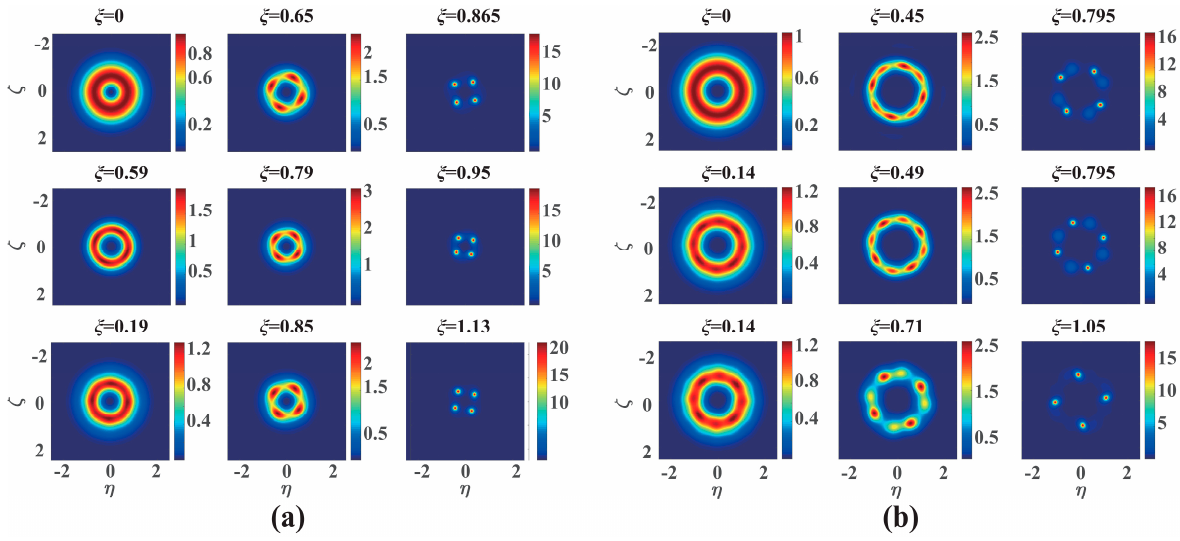
Figure 2. The evolution of vortex beams in a Kerr-ROLP medium for different modulation depths and modulation factors. ( a ) n = 1, P in = 1.7 P cr , the first to the third rows are, respectively, with V 0 = 0.2, d = 0.31; V 0 = 0.2, d = 0.23; V 0 = 0.7, d = 0.23. ( b ) n = 2, P in = 1.4 P cr , the first to the third rows are, respectively, with V 0 = 0.9, d = 0.31; V 0 = 0.9, d = 0.23; V 0 = 1.8, d = 0.23.